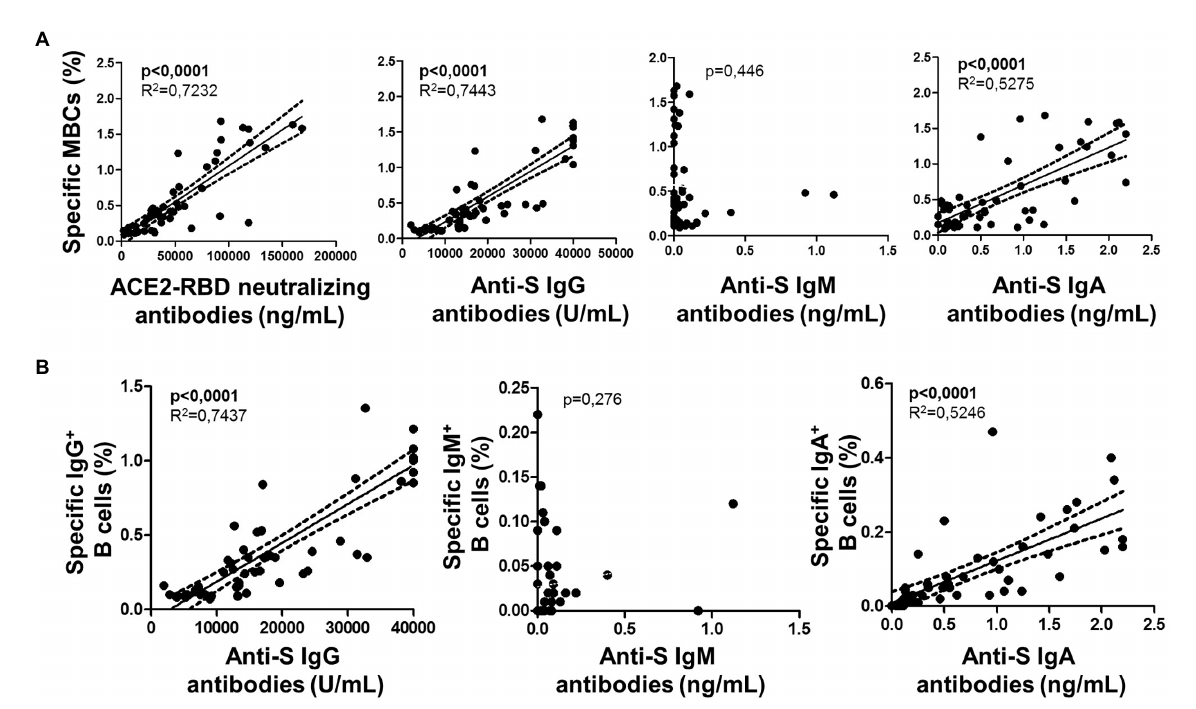
FIGURE 8 (A) Association of specific memory B cells (MBCs) with ACE2-RBD neutralizing antibodies, anti-S IgG, IgM and IgA antibodies after the complete vaccine regimen. (B) Associations of specific IgG B cells with anti-S IgG, IgM and IgA antibodies. Pearson’s correlation r value and two-tailed p values are shown only with statistical significance ( p < 0.05).